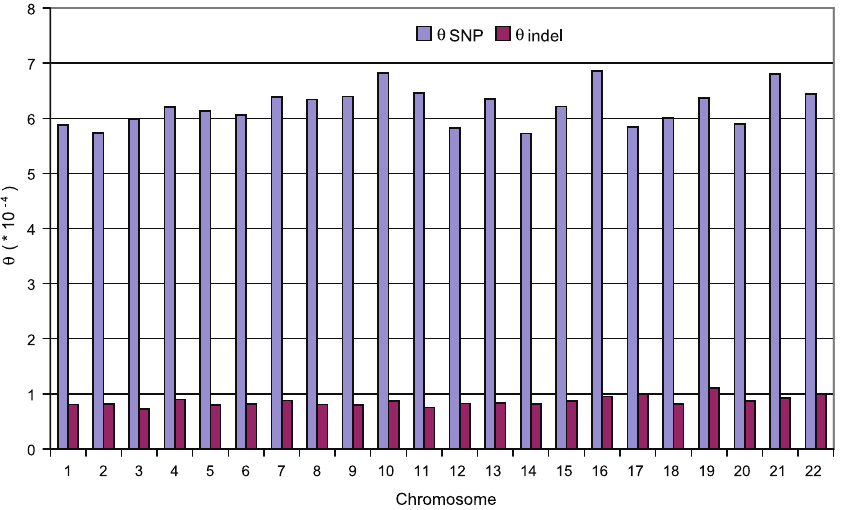
Figure 5. Diversity for SNPs and Indels in Autosomes This is most likely an under-estimate of the true diversity, because a fraction of real heterozygotes were missed due to insufficient read coverage.